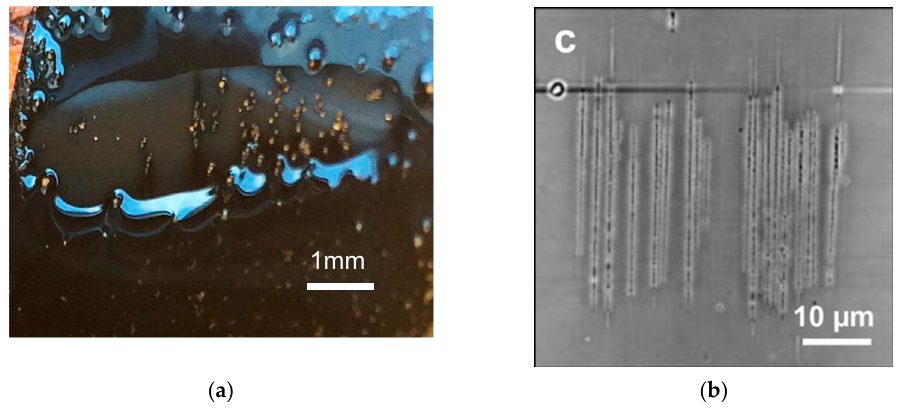
Figure 3. Top view images of the laser-induced thermocapillary ruptures: ( a ) the rupture of hexadecane layer ( ~ 1 mm thick) on a wetted soft magnetic disc caused by a line beam of IR laser. Residual polyethylene particles are captured by receding three phase contact line in the rupture area; ( b ) selective trench formation in the thermocapillary resist layer caused by laser exposure [30]. Trenches of ∼ 20 nm in the depth, ~ 100 nm in the width and around 60 μ m length. Reprinted with permission from ACS Nano, 2014, 8, 12641. Copyright 2022 American Chemical Society.